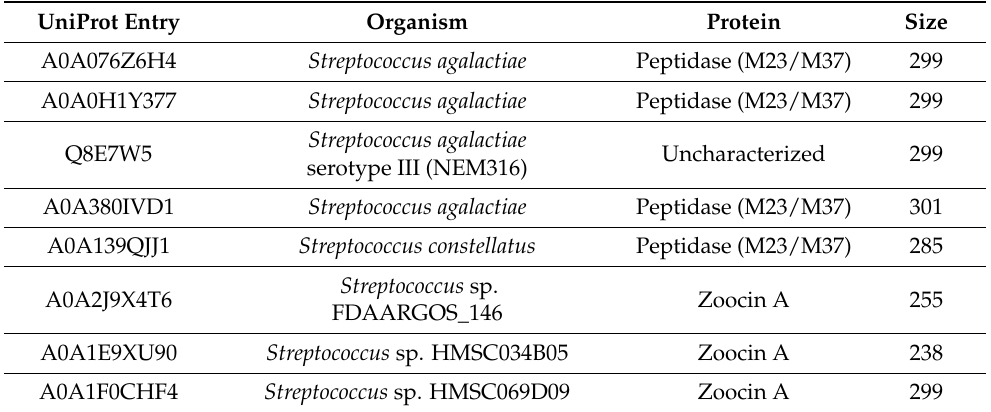
Table 3. UniProt entries for the protein sequences used in the multiple sequence alignment against the LGMAI’s putative zoocin